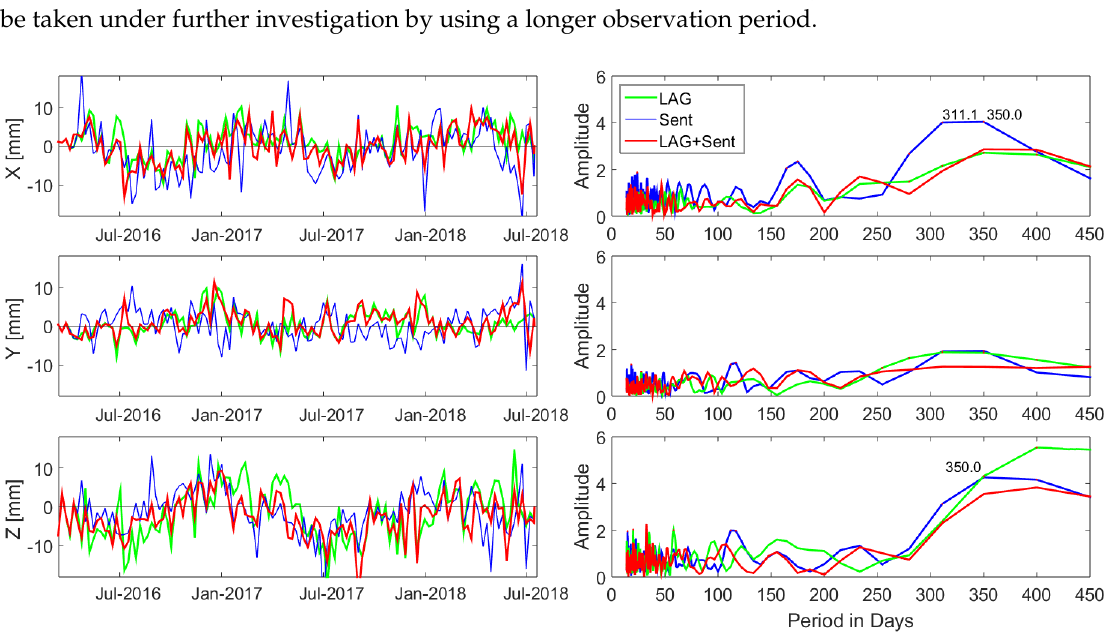
Figure 11. Comparison of geocenter coordinates ( left ) and the spectral analysis ( right ) for LAG (green), Sent (blue), and LAG+Sent (red)